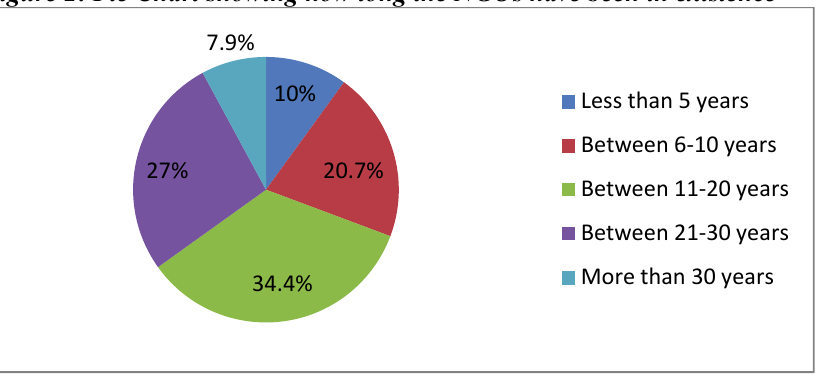
Figure 2: Pie Chart showing how long the NGOs have been in existence